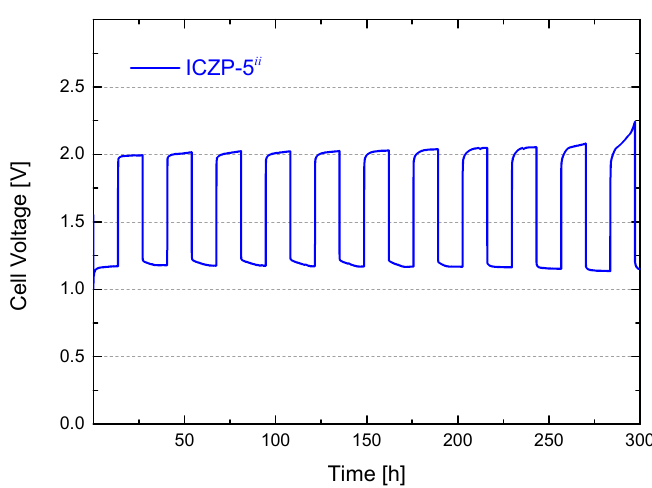
Figure 8. Cell voltage features for 5 wt. % ionomer-coated (ICZP-5) Zn particles in modified aqueous alkaline electrolyte ( ii : 4s-2) cycled at current density j d = j c = 1 mA cm − 2 for t d = t c = 13.5 h (capacity (d/c) = 35 mAh).